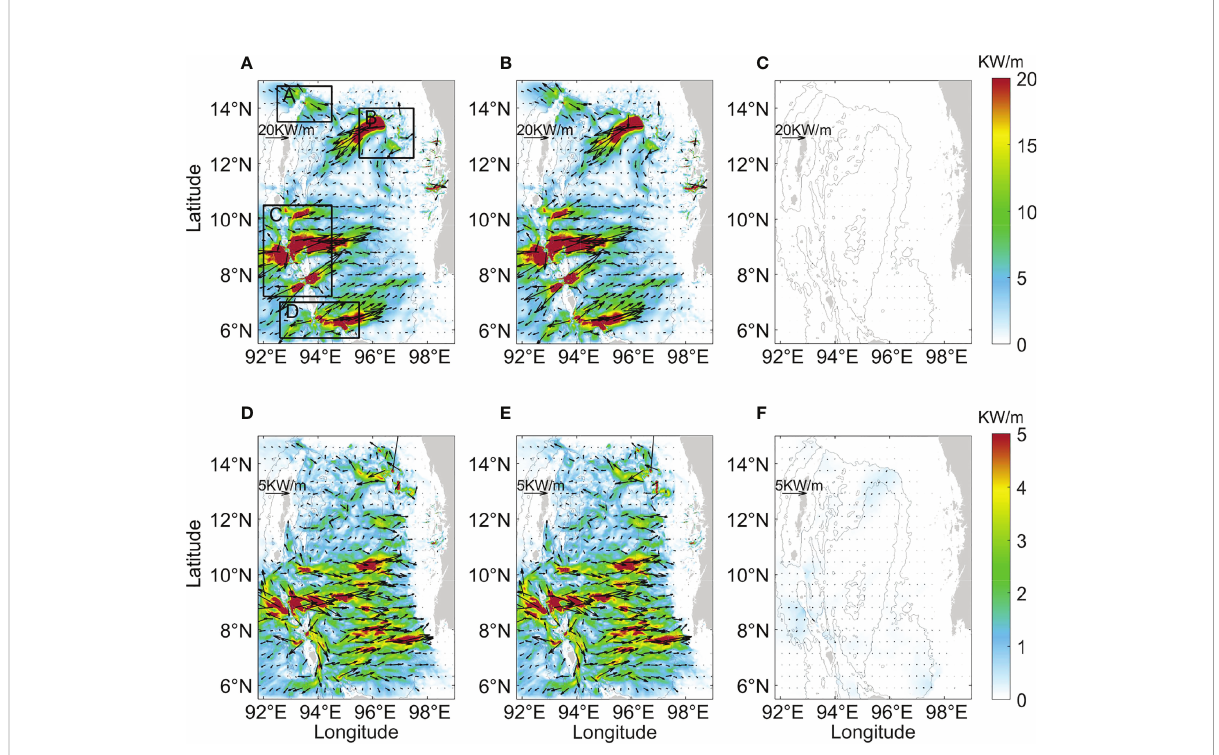
FIGURE 12 Spatial distribution of the time-averaged depth-integrated baroclinic energy fl ux in the (A, D) Experiment 1, (B, E) Experiment 2, and (C, F) Experiment 3. The period of (A – C) is spring tide, and the range of color scale is 0~20KW/m; the period of (D – F) is neap tide, and the range of color scale is 0~5KW/m. The color shade indicates the magnitude of the baroclinic energy fl ux, and the arrows indicate the direction of the baroclinic energy fl ux. The four rectangles in the panel (A) present the main generation subdomains of internal tides. Bathymetry contours are spaced at 500 and 2000